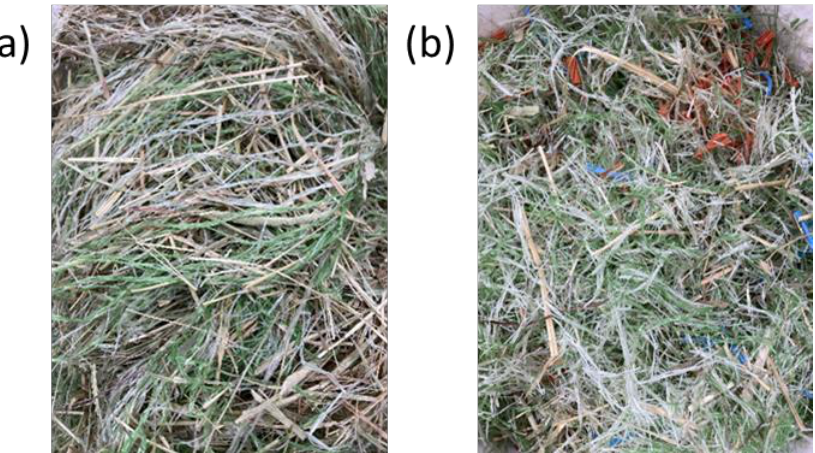
Figure 10. Photographs showing ( a ) Chaff Mixed Plastic (CMP), ( b ) Bluegrass Mixed Plastic (BMP) as received.